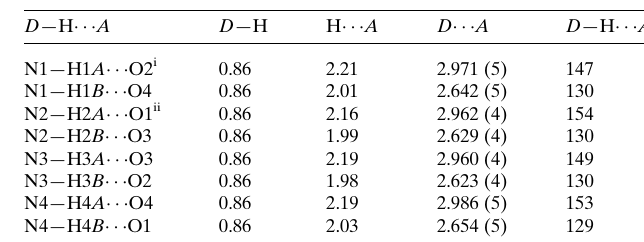
Table 1 Hydrogen-bond geometry (A˚ , (cid:2) ).